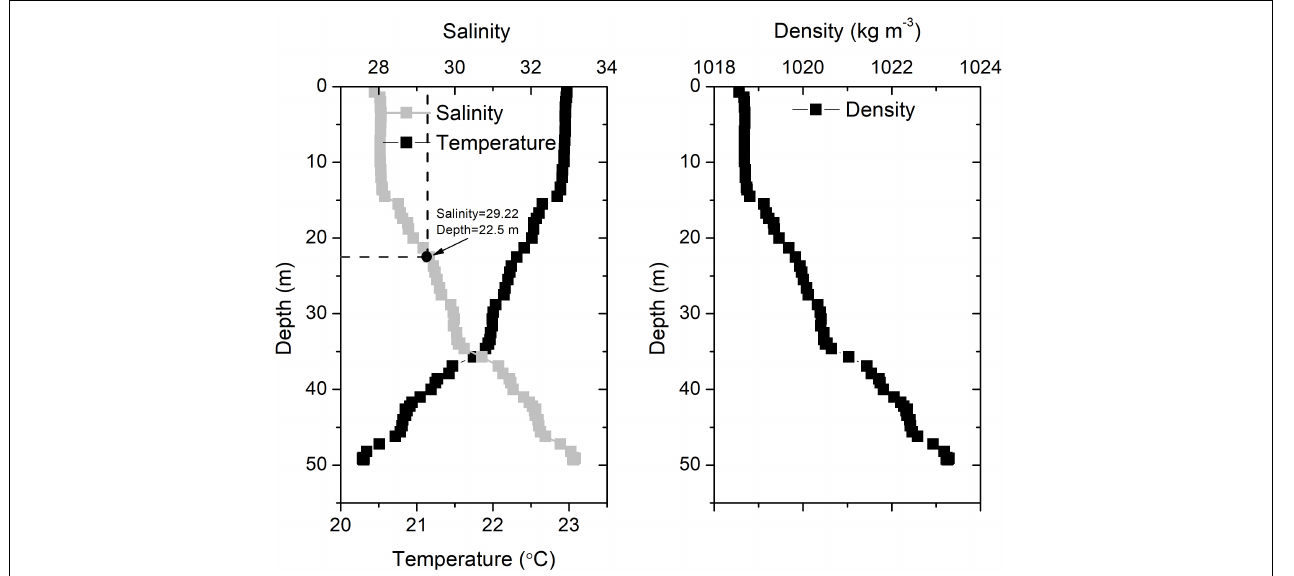
FIGURE 6 | Vertical salinity, temperature, and water density profiles around the buoy on July 17, 2015.